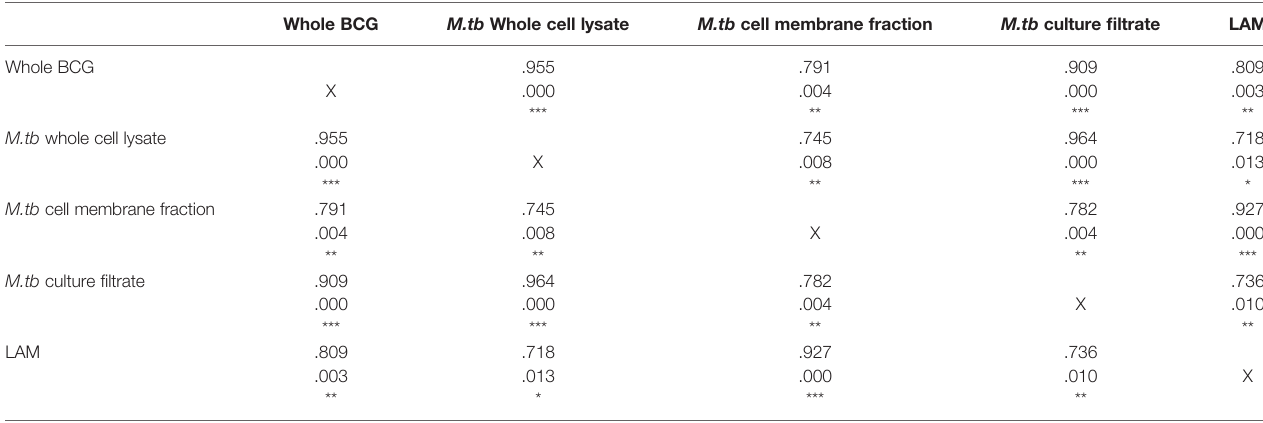
TABLE 2 | Spearman ’ s correlations between fold change (post-vaccination/baseline) in IgG speci fi c to different mycobacterial fractions following BCG vaccination in serum collected from Nepalese military